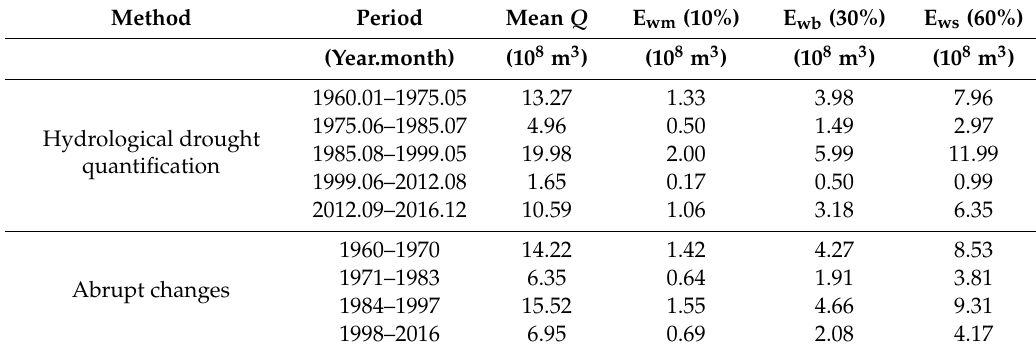
Table 3. The ecological water requirement for minimum (E wm ), basic (E wb ), and suitable (E ws ) environmental flow (e-flow) during different hydrological periods.